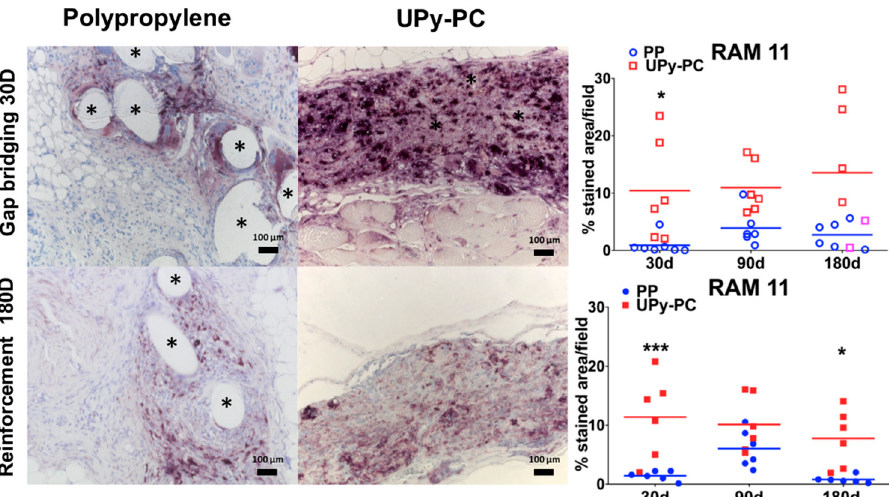
Figure 3. Inflammatory response. Representative images of RAM11 immunostaining at 200 × magnification (macrophages stained brown). Mesh filaments are marked by asterisk. A higher abundance of macrophages was around UPy-PC filaments at 30 days in both models, and at 180 days in the reinforcement model. * p ≤ 0.05, *** p ≤ 0.001 Herniated samples are marked by a lighter colour (pink). PP: Polypropylene; UPy-PC: electrospun ureidopyrimidinone polycarbonate.